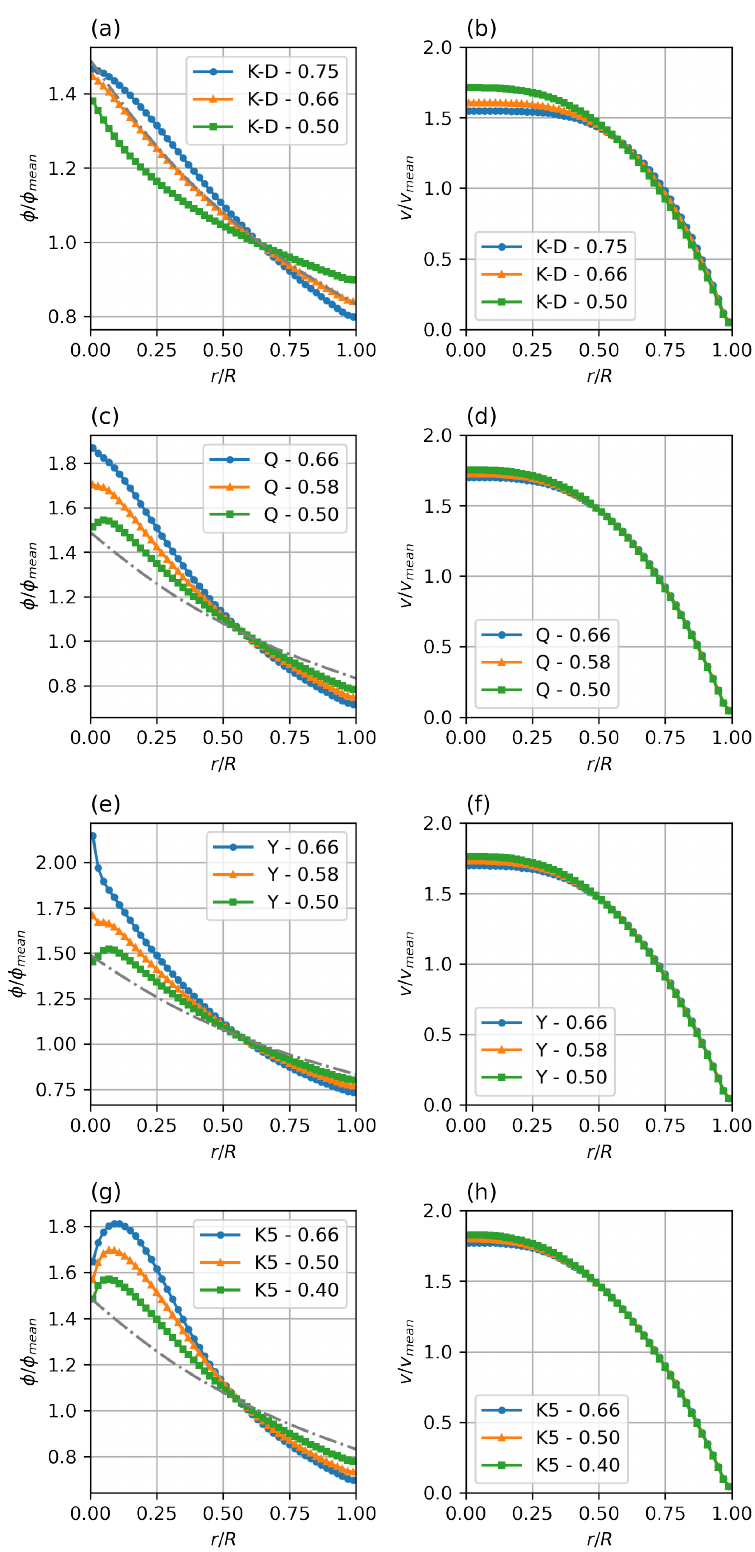
Figure 7. Steady state particle distribution ( a , c , e , g ) and velocity profiles ( b , d , f , h ) for different viscosity models and collision parameter ratios ( K c / K µ ). Parameters: fully developed pipe flow, R = 0.05 mm, V = 0.0065 m s − 1 , K c / K µ = 0.4–0.75 (given in legends). Standard Krieger–Dougherty ( a , b ), Quemada ( c , d ), Yeleswarapu ( e , f ), and modified 5-parameter Krieger ( g , h )